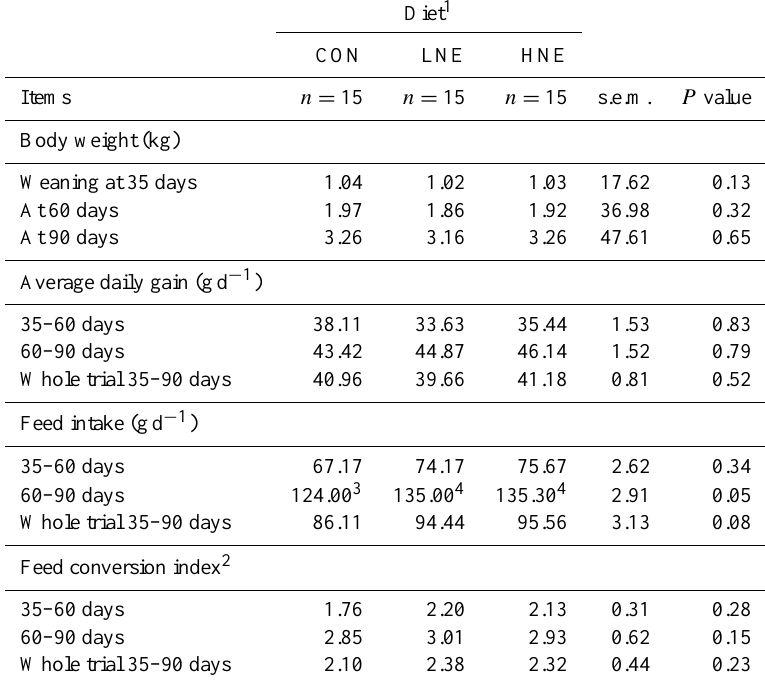
Table 2. Effect of Lippia citriodora extract on productive performance in growing New Zealand white rabbits.